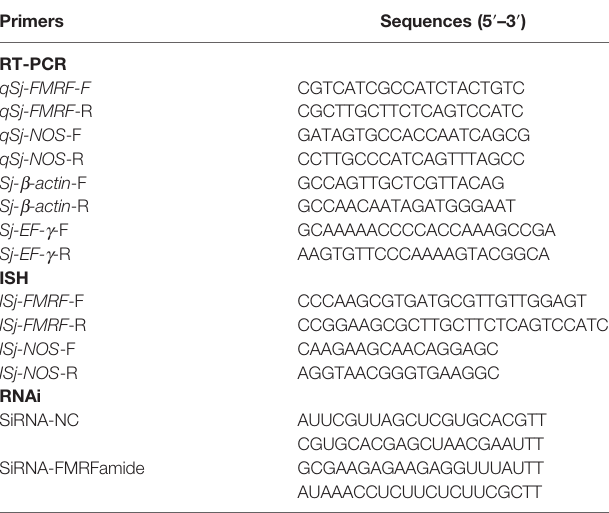
TABLE 1 | Primers used in the study.